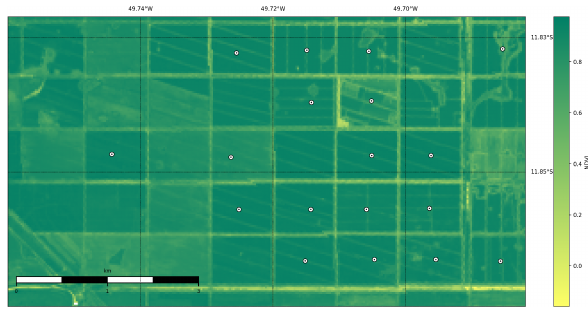
Figure 7. Agricultural field detected.